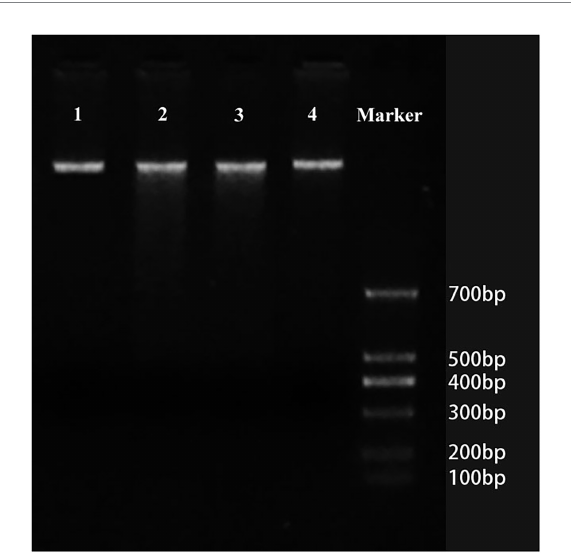
FIGURE 3 Cleavage of nuclear DNA during aerenchyma formation in Nelumbo nucifera by agarose gel electrophoresis. No obvious DNA smears or DNA ladders were observed in the stationary stage (lane 1), formation stage (lane 2), expansion stage (lane 3), and mature stage (lane 4), indicating that the DNA fragmentation was not detected in the DNA gel electrophoresis during the aerenchyma formation in N. nucifera